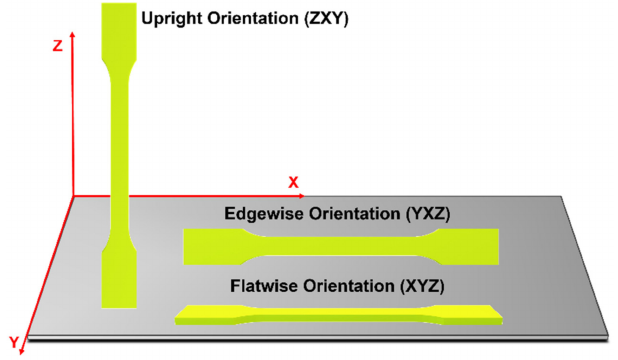
Figure 12. Build orientation.